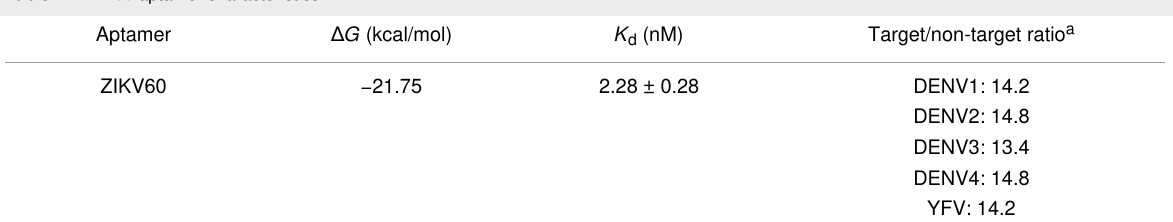
Table 1: ZIKV60 aptamer characteristics.